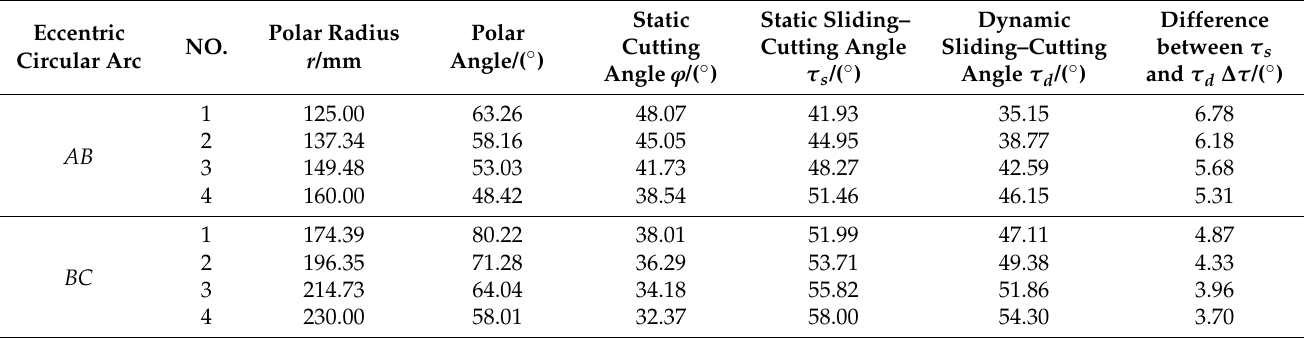
Figure 5. Speed analysis of cutting edge of rotary blade, where D is an arbitrary point on the rotary blade cutting edge; n - n is the normal line at point D ; m - m is the tangent line at point D . After all the double-eccentric circle cutting-edge parameters were determined, four points were selected proportionally on each of the eccentric arcs AB and BC to solve the dynamic sliding–cutting angle. The results are shown in Table 2. Table 2. Calculated values of parameters of edge curve of lengthwise blade.